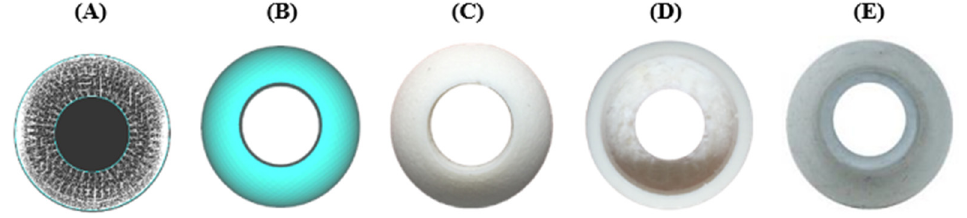
Figure 5. 3D CAD to 3D printed flexible TPU sclera development pipeline: ( A ) 3D CAD model created in 3DS Max; ( B ) model compiled in Cura 3D; ( C ) 3D printed sclera model in TPU front; ( D ) TPU Sclera rear; ( E ) finished model with vein details.